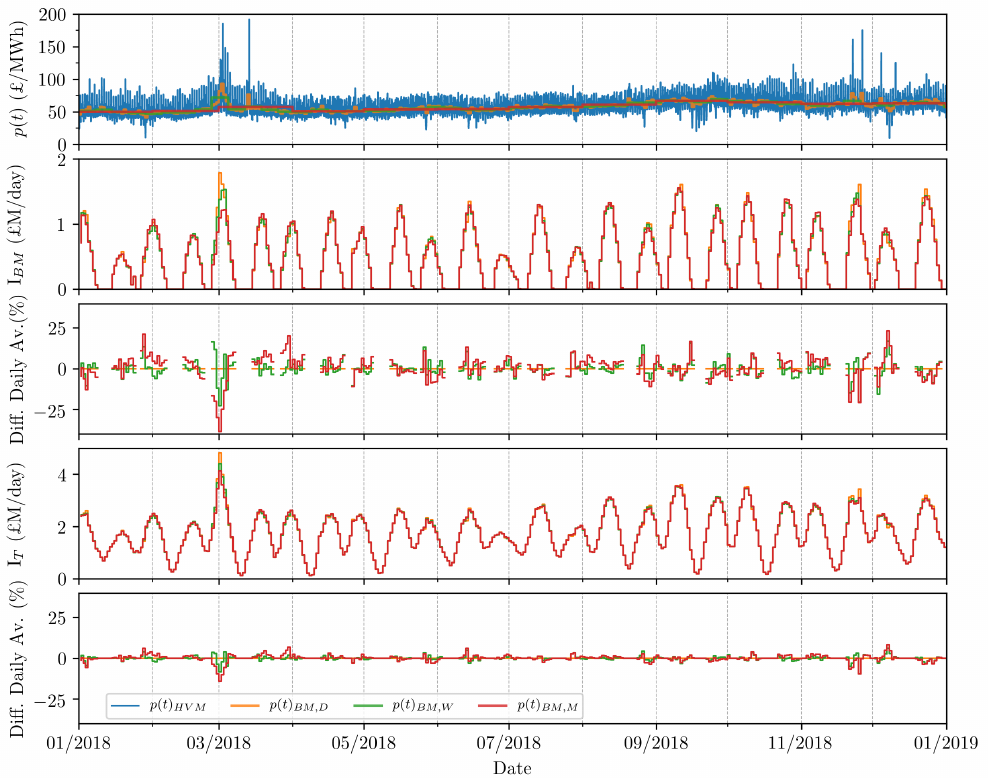
Figure 11. Tidal range power plant system daily income upon trading in baseload markets I BM and hourly variable markets I HVM (I BM + I HVM = I T ). Displayed results are from CG-F CG - I ,0 control schedule, which yields the highest baseload energy E CG of all optimisation cases. Percentage difference between daily averaged baseload price and the weekly and monthly equivalents is